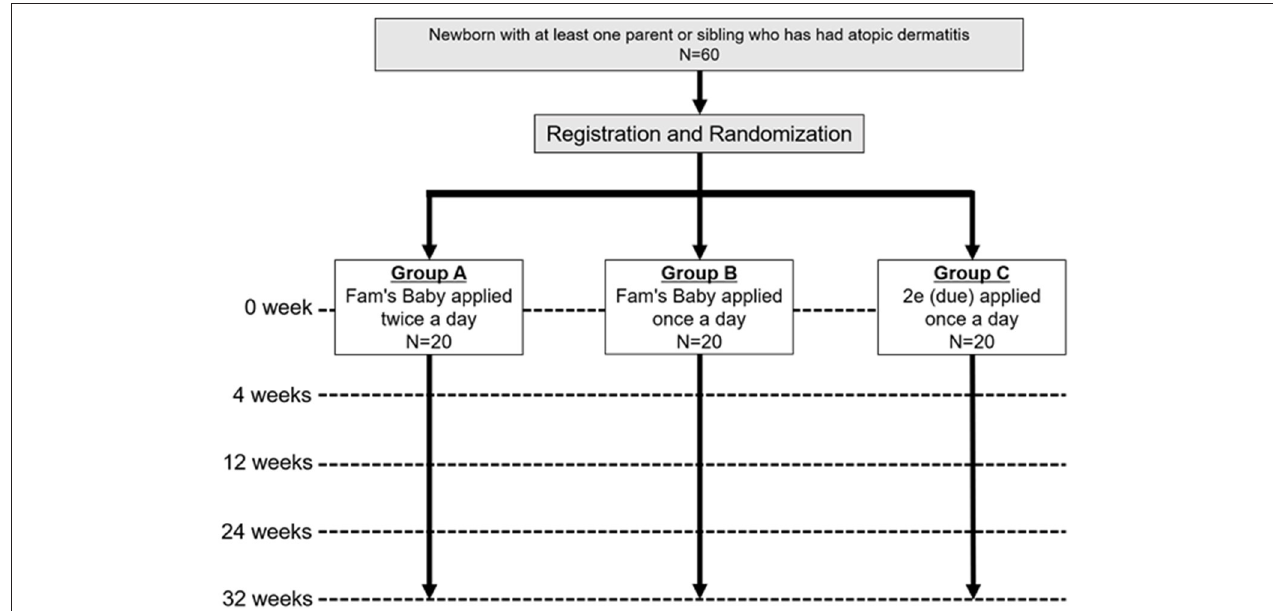
FIGURE 1 | Trial scheme. Newborns with at least one parent or sibling who has had atopic dermatitis will be recruited and enrolled. Participants will be assigned 1:1:1 to groups A, B, and C, and evaluated if they have AD at 4, 12, 24, and 32 weeks for each